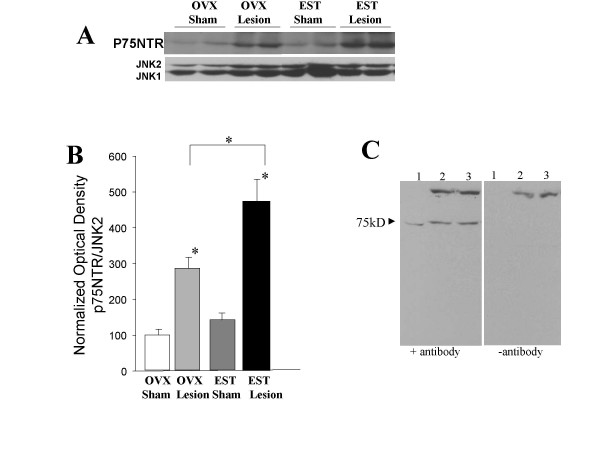
P75NTR regulation following olfactory bulb lesions: P75NTR expression was determined by Western blot assays (A) and receptor expression was quantified and normalized to a loading control (JNK) in the histogram (B). P75NTR was increased in lesioned animals, and estrogen treatment for 3 weeks prior to the lesion further enhanced the expression of this receptor. Two representative examples are shown of each treatment condition in the Western blots. Bars represent mean ± SEM, n = 6 per group. (C) Specificity of p75NTR antibody: The antibody used in this Western assay recognizes a size appropriate band at 75 kD, which is not seen when the membrane is probed in the absence of the primary antibody. Lane 1: PC12 cell lysate, Lanes 2,3: olfactory bulb lysate. Key: OVX Sham: Ovariectomized female replaced with a control pellet, with sham injection, OVX lesion: ovariectomized female replaced with a control pellet, with NMDA injection, Est Sham: ovariectomized female replaced with an estrogen pellet, with sham injection, Est Lesion: ovariectomized female replaced with an estrogen pellet, with NMDA injection. *: p < 0.05.